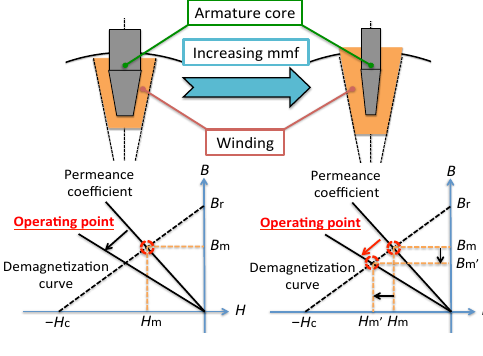
Figure 5: Process of motor design.